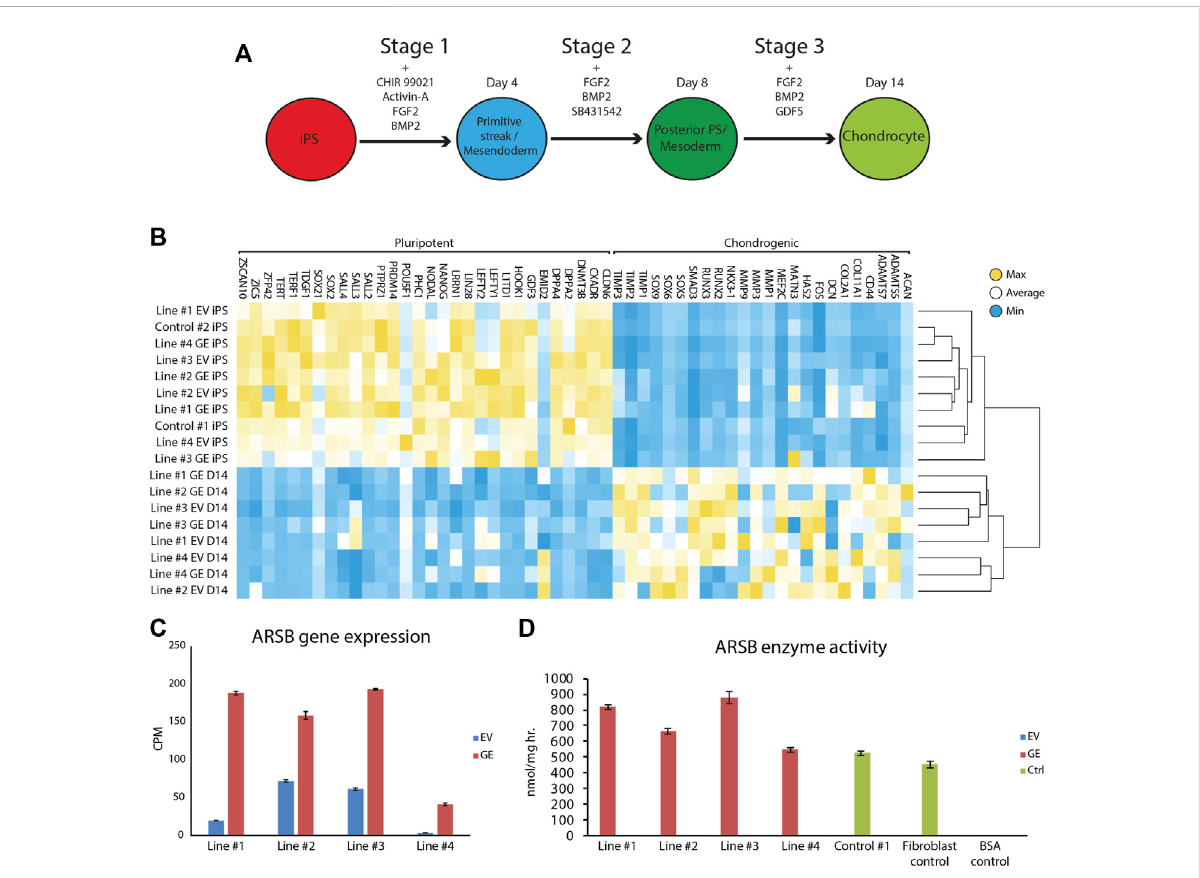
FIGURE 3 Differentiation of hiPSCs into chondrogenic cells. (A) Schematic representation of the re fi ned 14-day differentiation protocol. Different factors are added to the media during the three stages. Cells are passaged at the end of stage 1 and 2 at day 4 and 8, respectively. (B) Expression analysis of pluripotent and chondrogenic genes show a loss of pluripotency and an increase in expression of chondrogenic genes after the chondrogenic differentiation. Expression of POU5F1 was very high in hiPSC Line #3 EV relative to all other hiPSC lines, resulting in a shift of the mean expression valuefor thisgeneusedtogeneratedtheheatmap.However,all hiPSClinesshoweddownregulationofPOU5F1upondifferentiation. (C) ARSBgeneexpressionremainedhighafterchondrogenicdifferentiation( n =3). (D) BiochemicalanalysisshowedarescueofARSBenzymeactivityin chondrogenic cells (n = 3). GE: Gene edited with ARSB cDNA, EV: Gene edited with empty vector control. Data are expressed as means ±